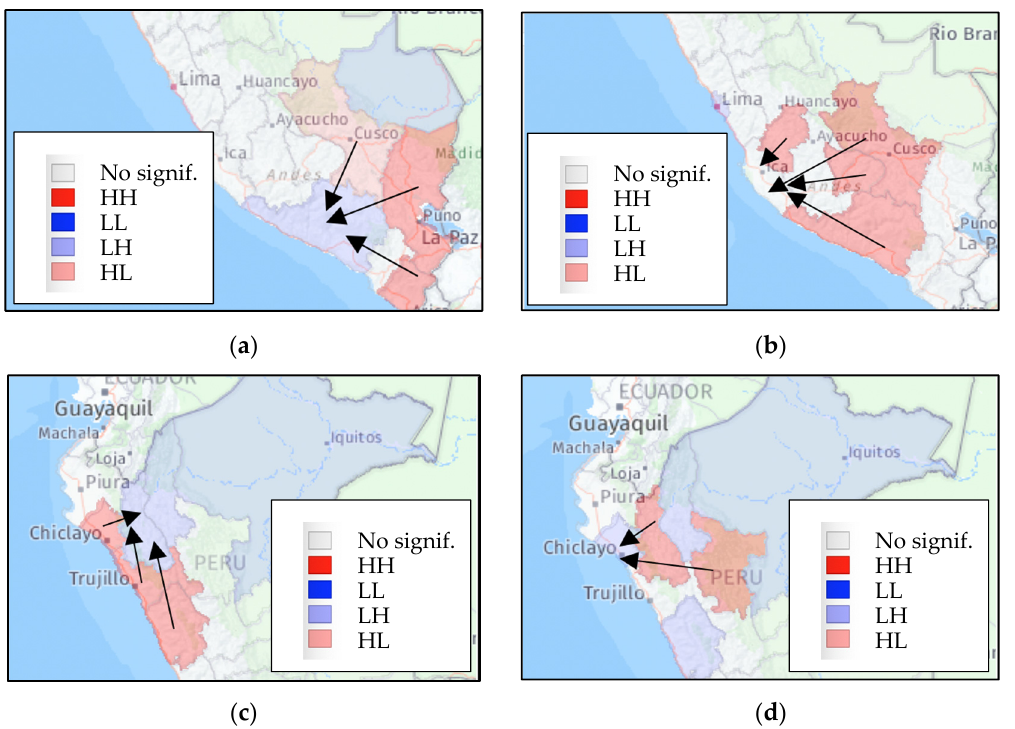
Figure 3. Clusters in origin regions created by destination regions: ( a ) Destination: Arequipa; ( b ) Destination: Ica; ( c ) Destination: Cajamarca; ( d ) Destination: Lambayeque.